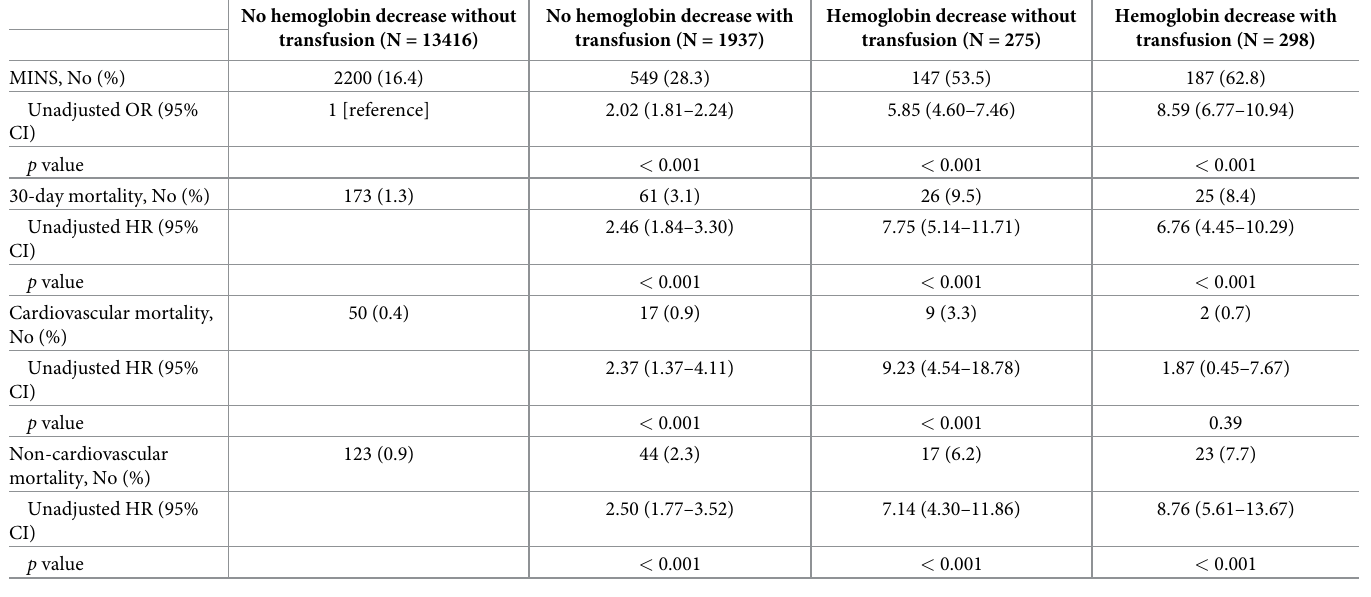
Table 3. The incidence of myocardial after noncardiac surgery and mortality according to intraoperative hemoglobin decrease and transfusion. No hemoglobin decrease without transfusion (N =